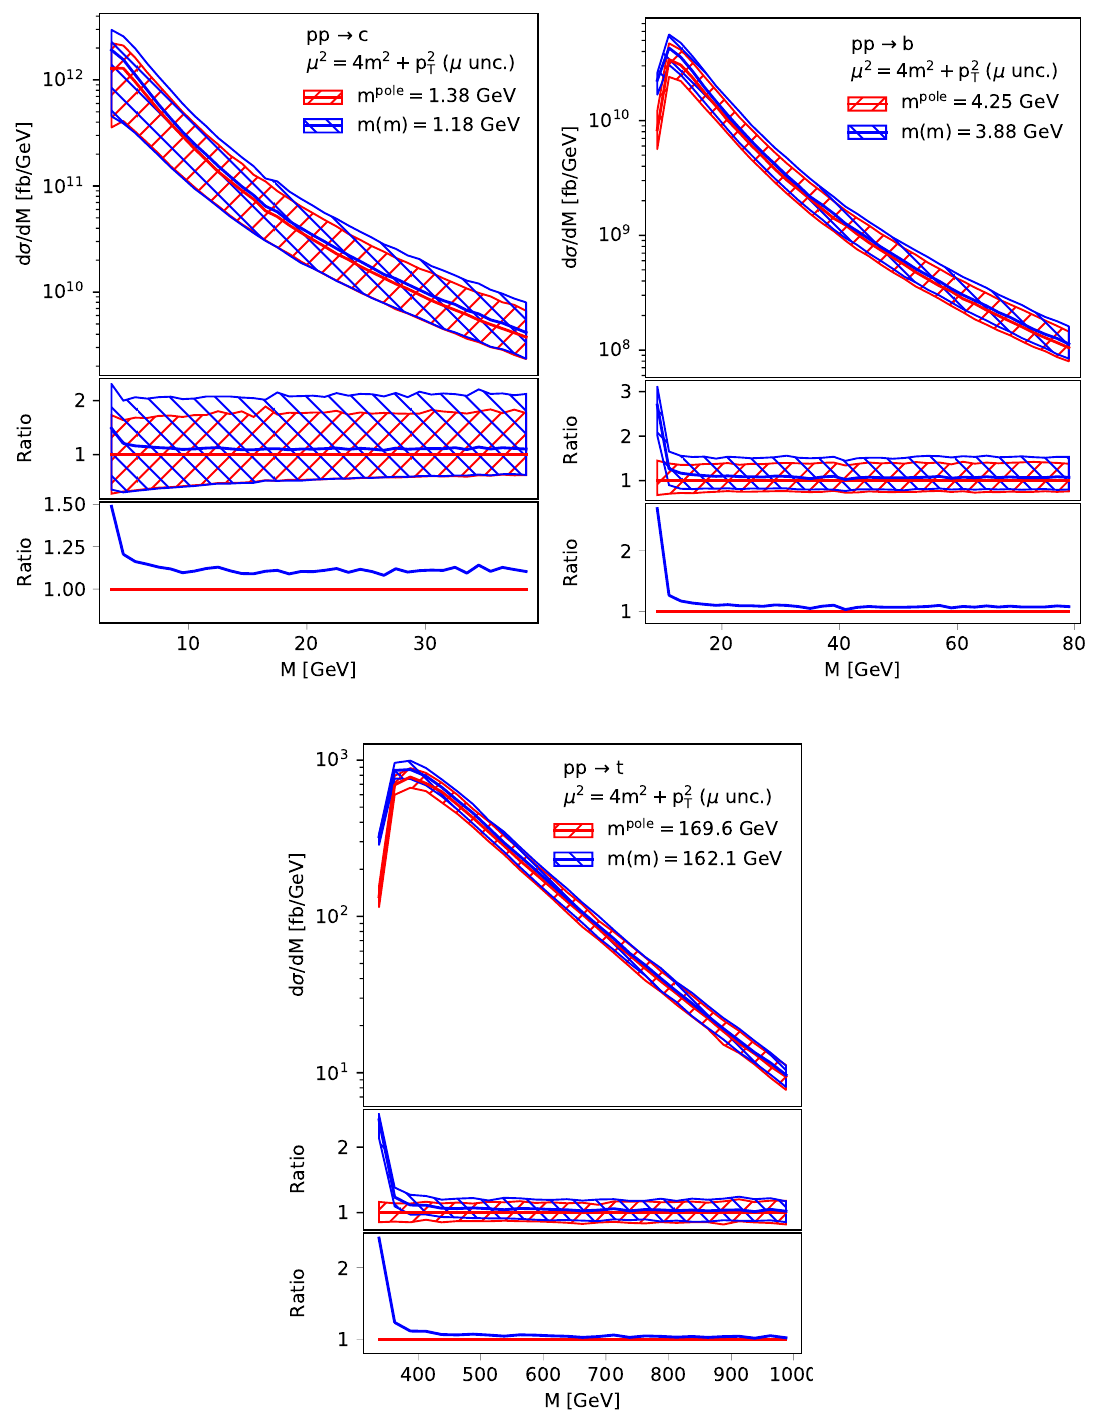
Figure 13 . Same as figure 12 but for heavy-flavor MS mass values corresponding to those extracted in the ABMP16 NLO